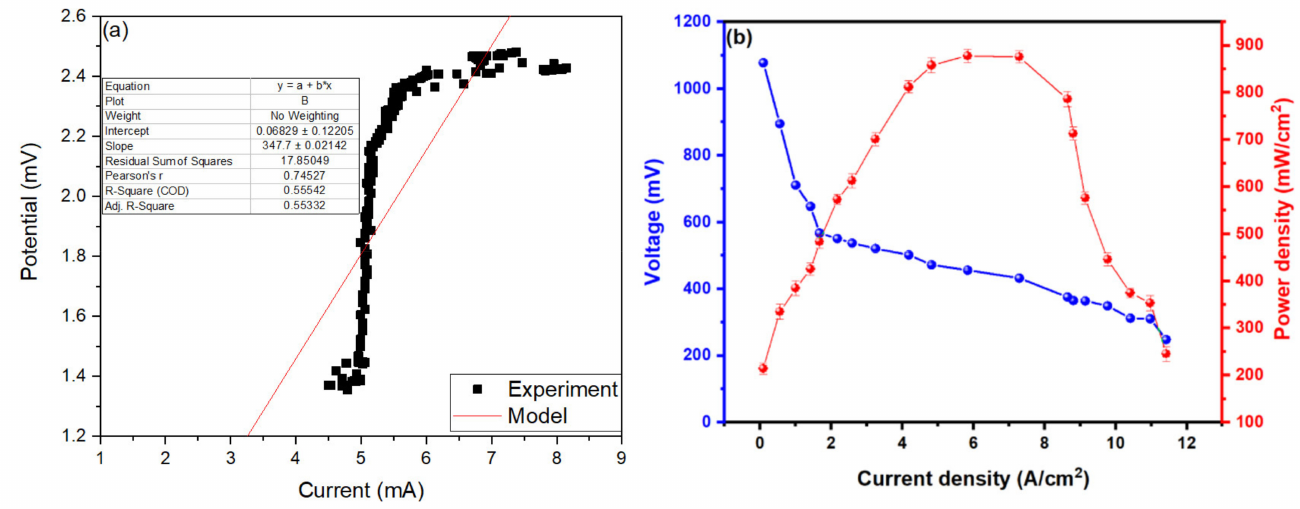
Figure 4. Characterisation of ( a ) internal resistance and ( b ) power and voltage density in relation to the current density of